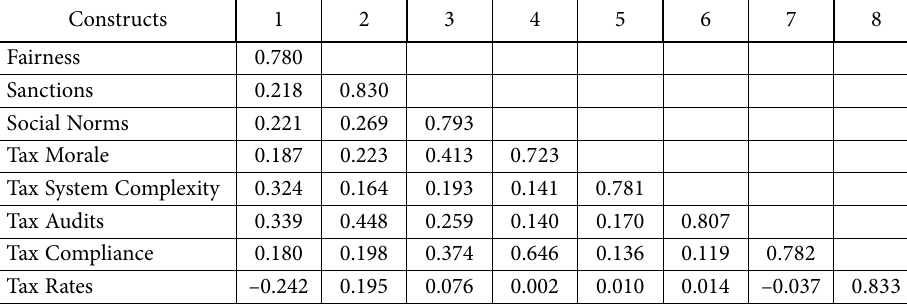
Table 4. Discriminant validity